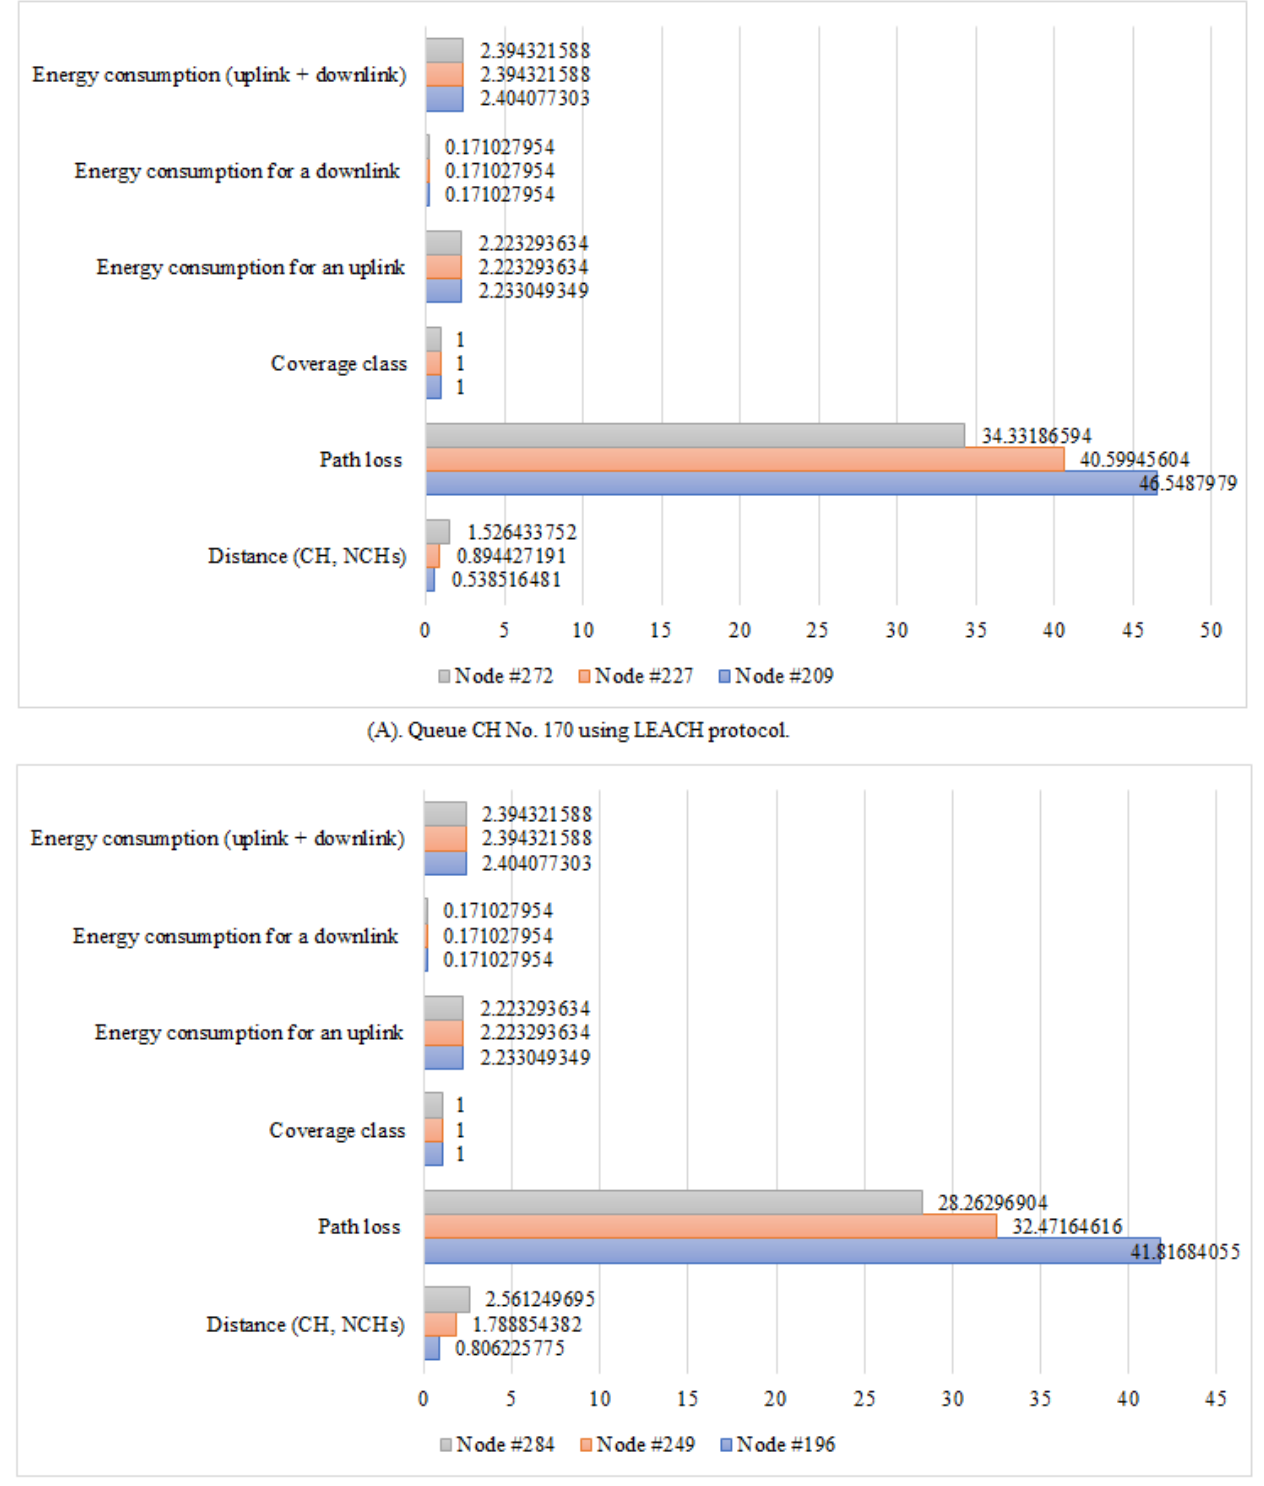
Figure 27. Queue CHs No. 170 and No. 171 using LEACH